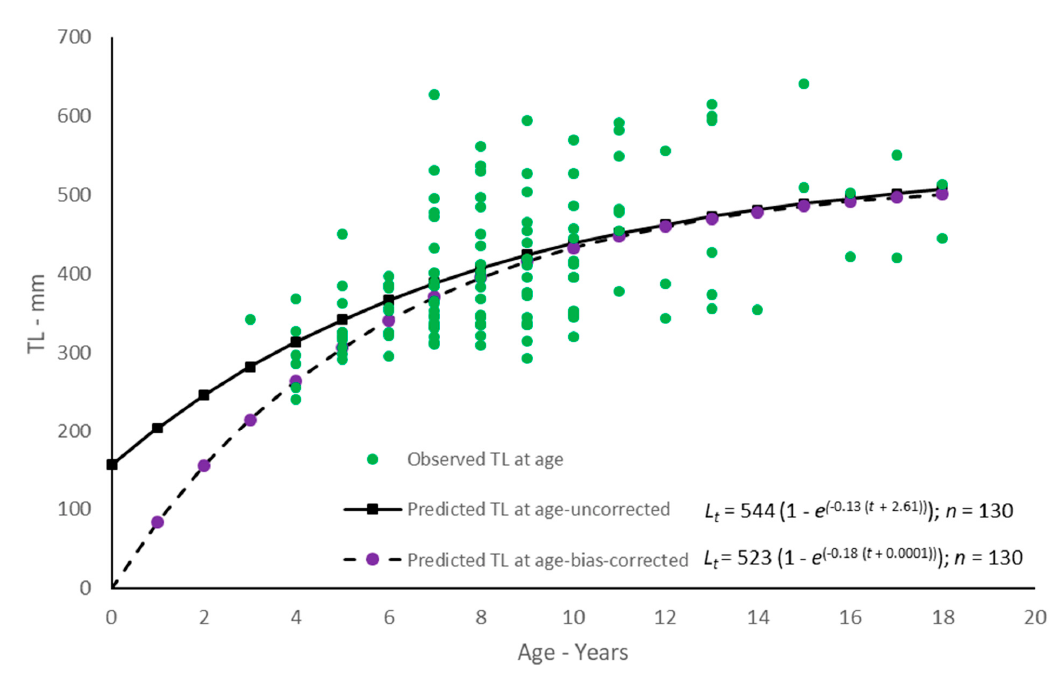
Figure 5. Comparison of observed size-at-calendar-age of black margate ( Haemulon album ) to the predicted von Bertalanffy growth curves for fish from the Southeastern United States. The bias-corrected model was run due to the lack of younger fish in our samples.